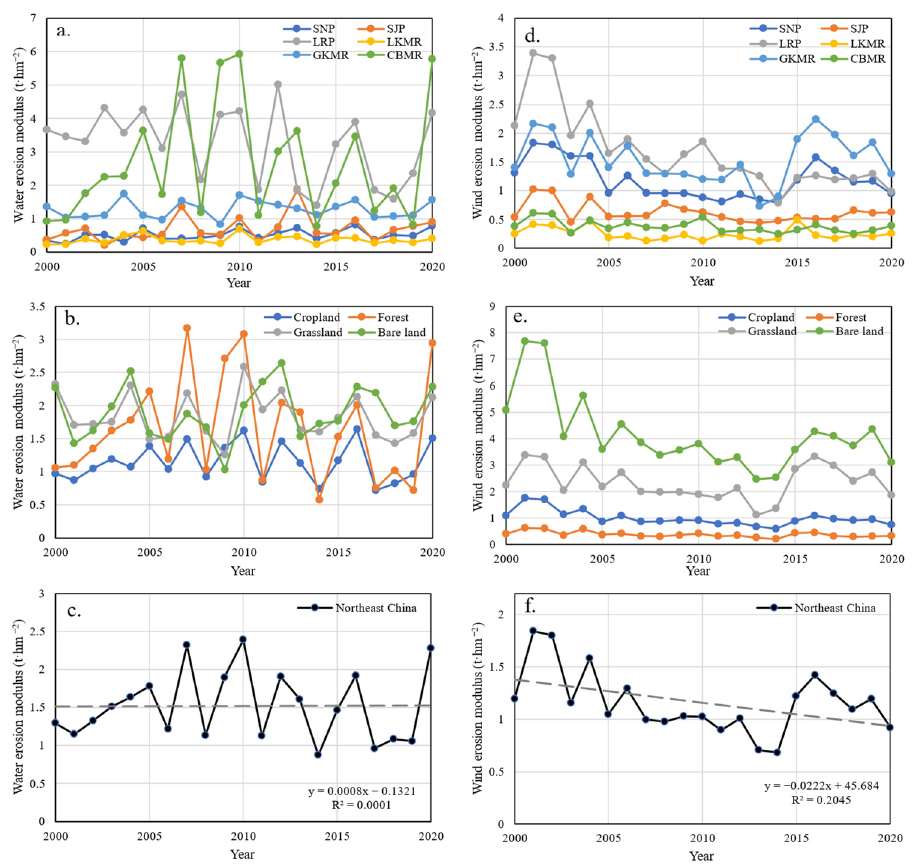
Figure 5. Year-by-year changes of water erosion ( a – c ) and wind erosion ( d – f ) modulus: in different geo-graphic sub-regions ( a , d ), types of ecosystems ( b , e ), and Northeast China ( c , f ) from 2000 to 2020.